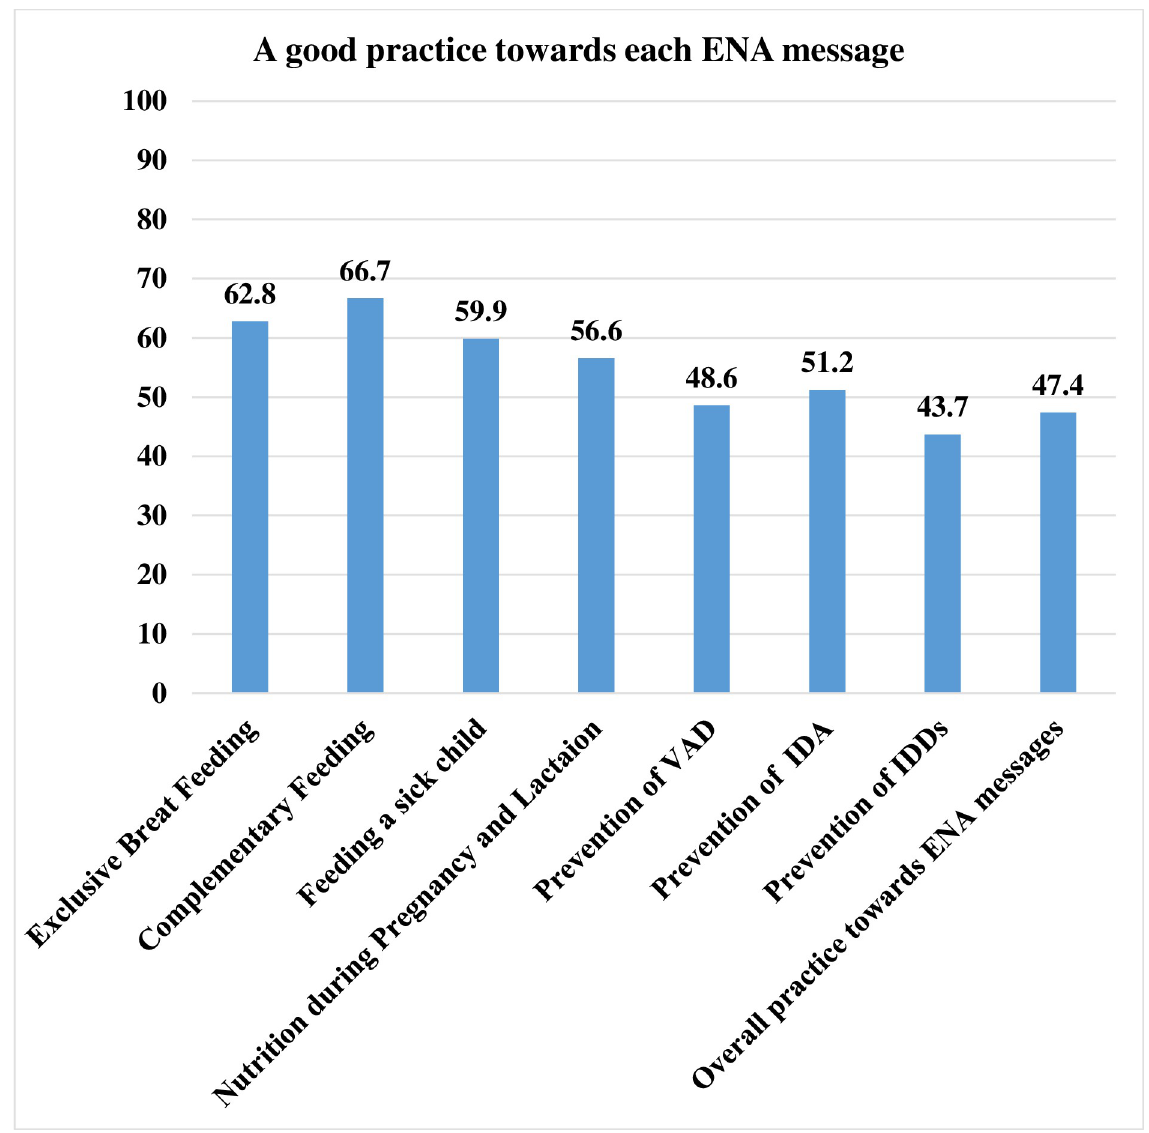
Fig 3. Distribution of uptake of key ENA messages among mothers of children aged 6–24 months in Lemo District, Southern Ethiopia, 2021.